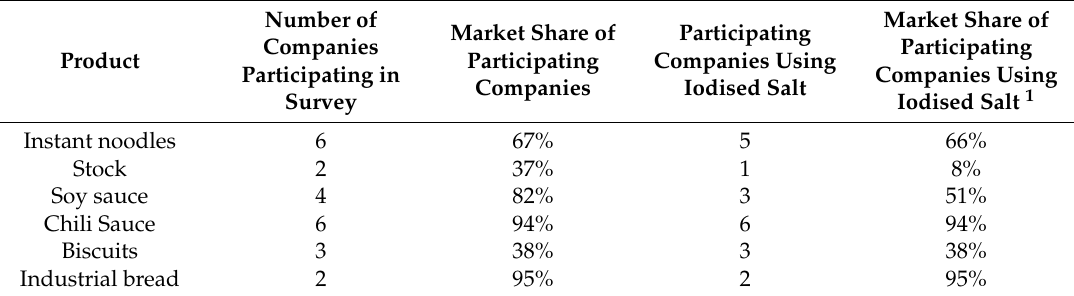
Table 2. Overview of food industry survey participants, food products and market share, and use of iodised salt,